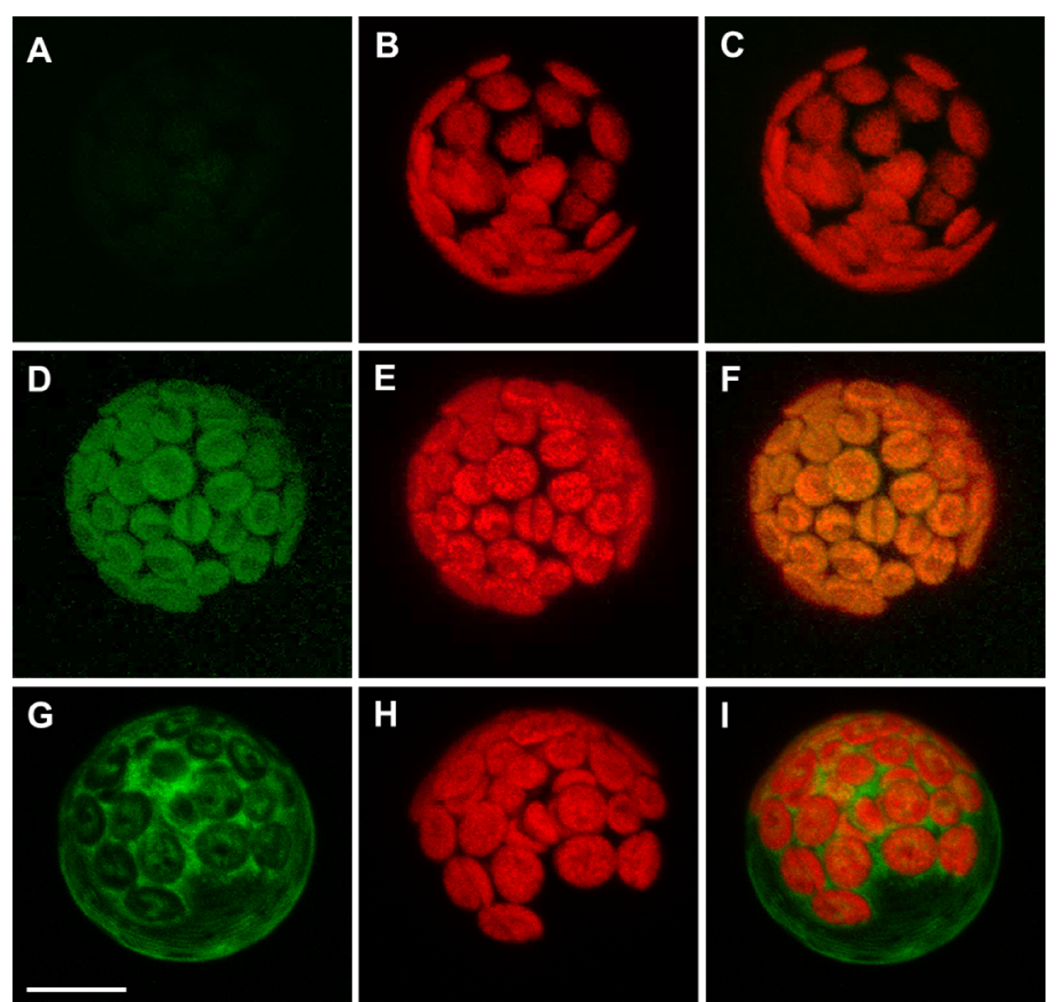
Figure 2. A. thaliana APx-R-YFP is targeted to chloroplasts. Confocal microscope images of transient expression assay performed on A. thaliana mesophyll protoplasts: ( A – C ) non-transformed cells; ( D – F ) expression of a carboxi-terminal YFP fusion; and ( G – I ) expression of amino-terminal YFP fusion. ( A , D , G ) YFP fluorescence; ( B , E , H ) chlorophyll autofluorescence; and ( C , F , I ) merge. Scale: 8 µm